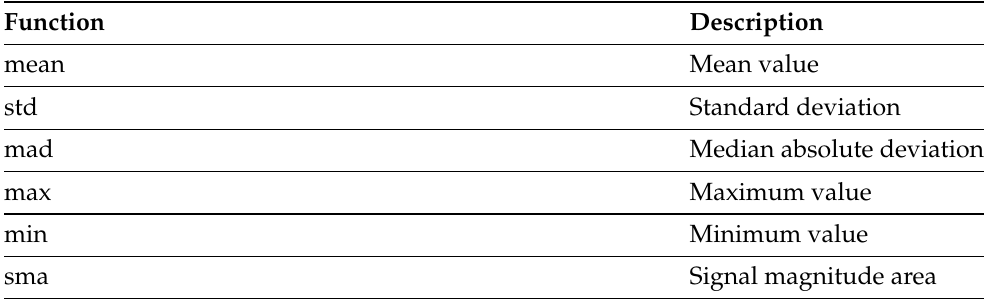
Table 1. List of calculated measures of the windowed signals of the UCI HAR Smartphone dataset [31].